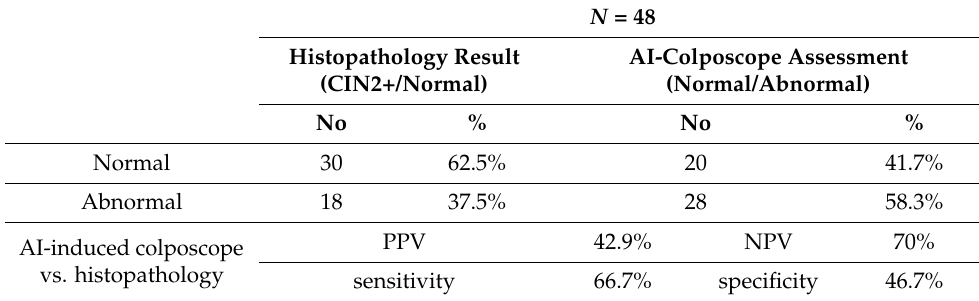
Table 2. Histopathological assessment of the biopsy samples compared to the AI-induced colposcopy